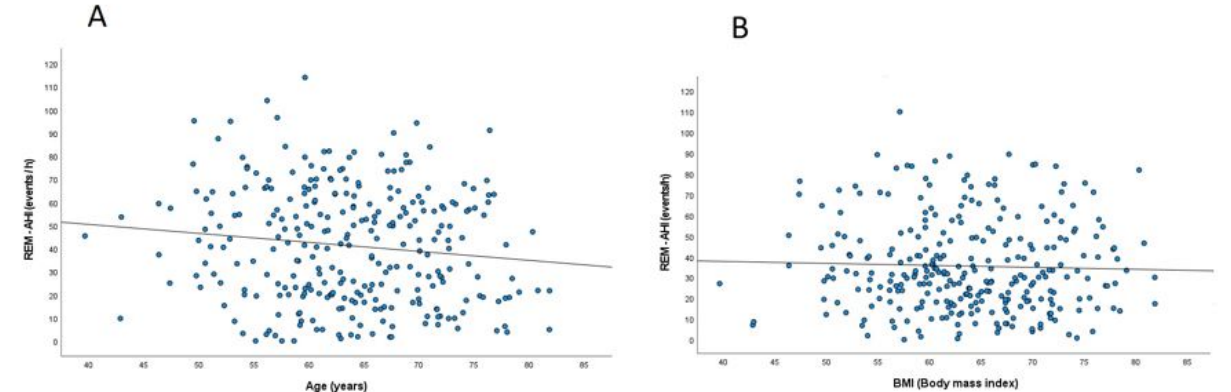
Figure 2 . ( A ). Pearson correlation between REM-AHI levels and age, ( B ). Pearson correlation anal- ysis between REM-AHI and BMI. Definition of abbreviations : AHI = apnea-hypopnea-index; BMI = body mass index; REM = rapid eye movements .